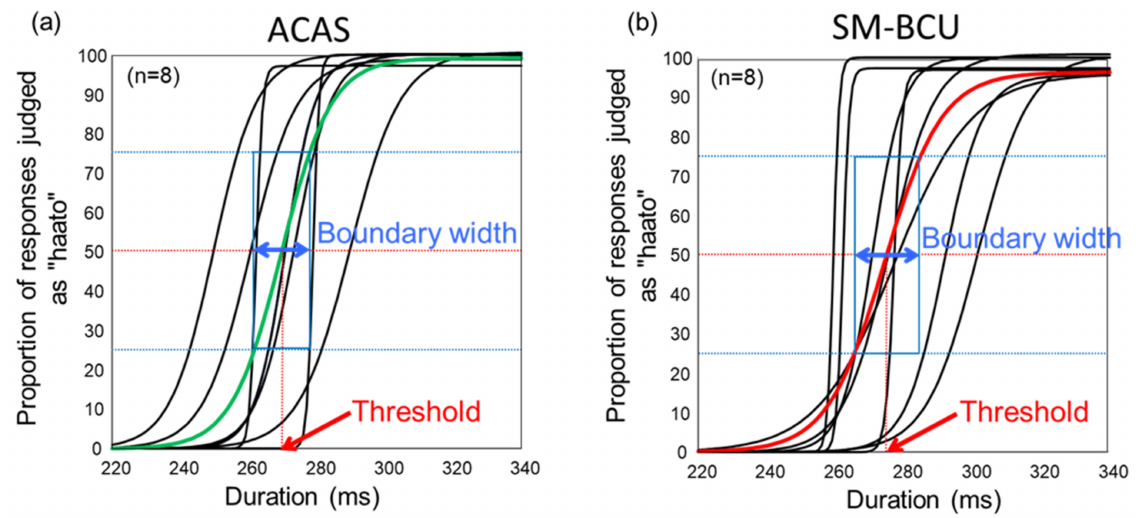
Figure 3. Logistic functions for air-conducted audible sound (ACAS) ( a ) and speech-modulated bone-conducted ultrasound (SM-BCU) ( b ).